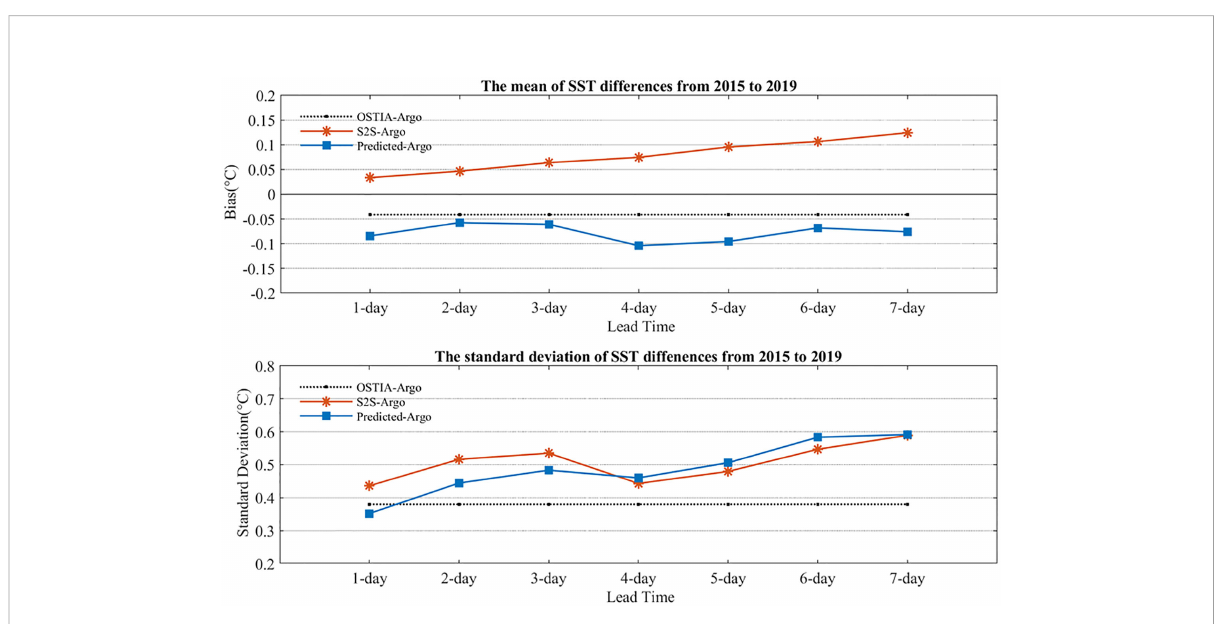
FIGURE 5 The mean and standard deviation of SST difference (red asterisks and line for the S2S-minus-Argo; blue square and line for the predicted SSTs- minus-Argo; dark dotted line for the OSTIA-minus-Argo) from 2015 to